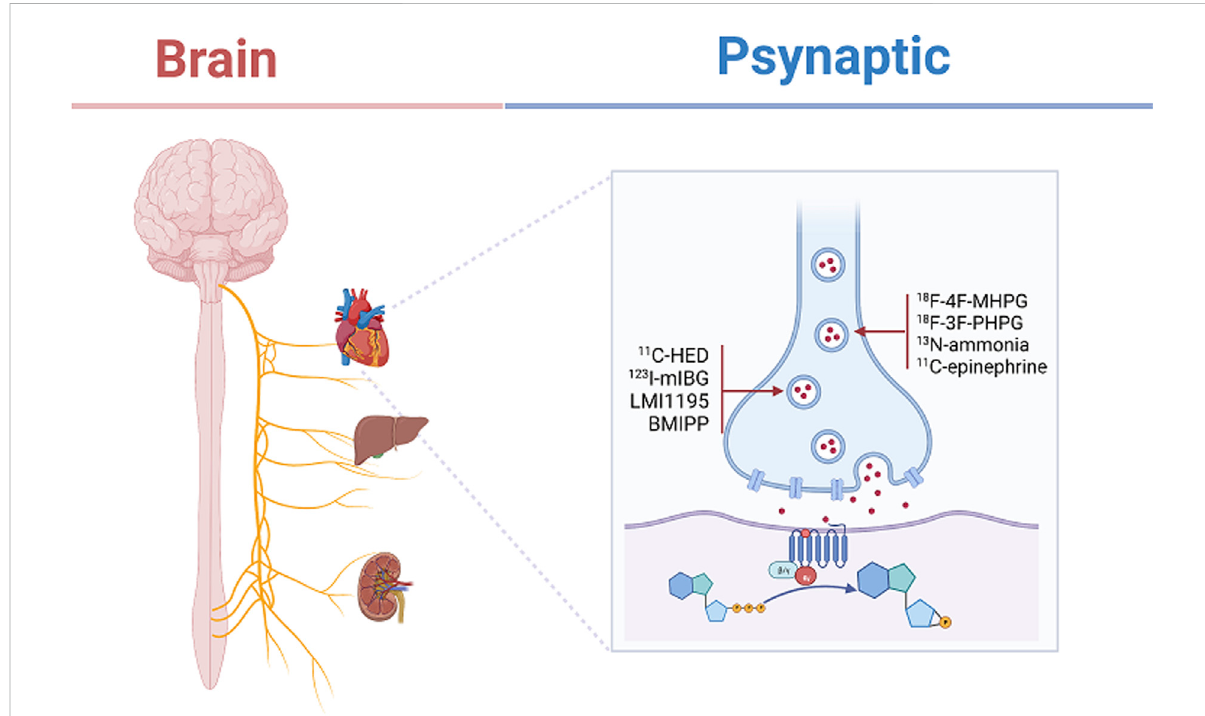
FIGURE 2 Depicts the present state of sympathetic innervation of transplanted hearts. Labeling of commonly used radioactive neurotransmitters in the presynaptic membrane, such as 11 C-hydroxyephedrine ( 11 C-HED), Iodine-123-meta-iodobenzylguanidine ( 123 I-mIBG), N